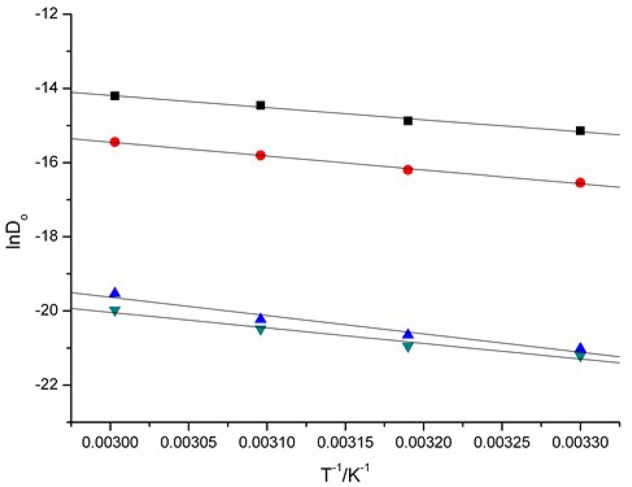
lnDo of Eu(III), as a function of T−1 measured in [C4mim][N(CN)2] (black), [C4m2im][N(CN)2] (red), N4442[N(CN)2] (blue), and N8444[N(CN)2] (green).